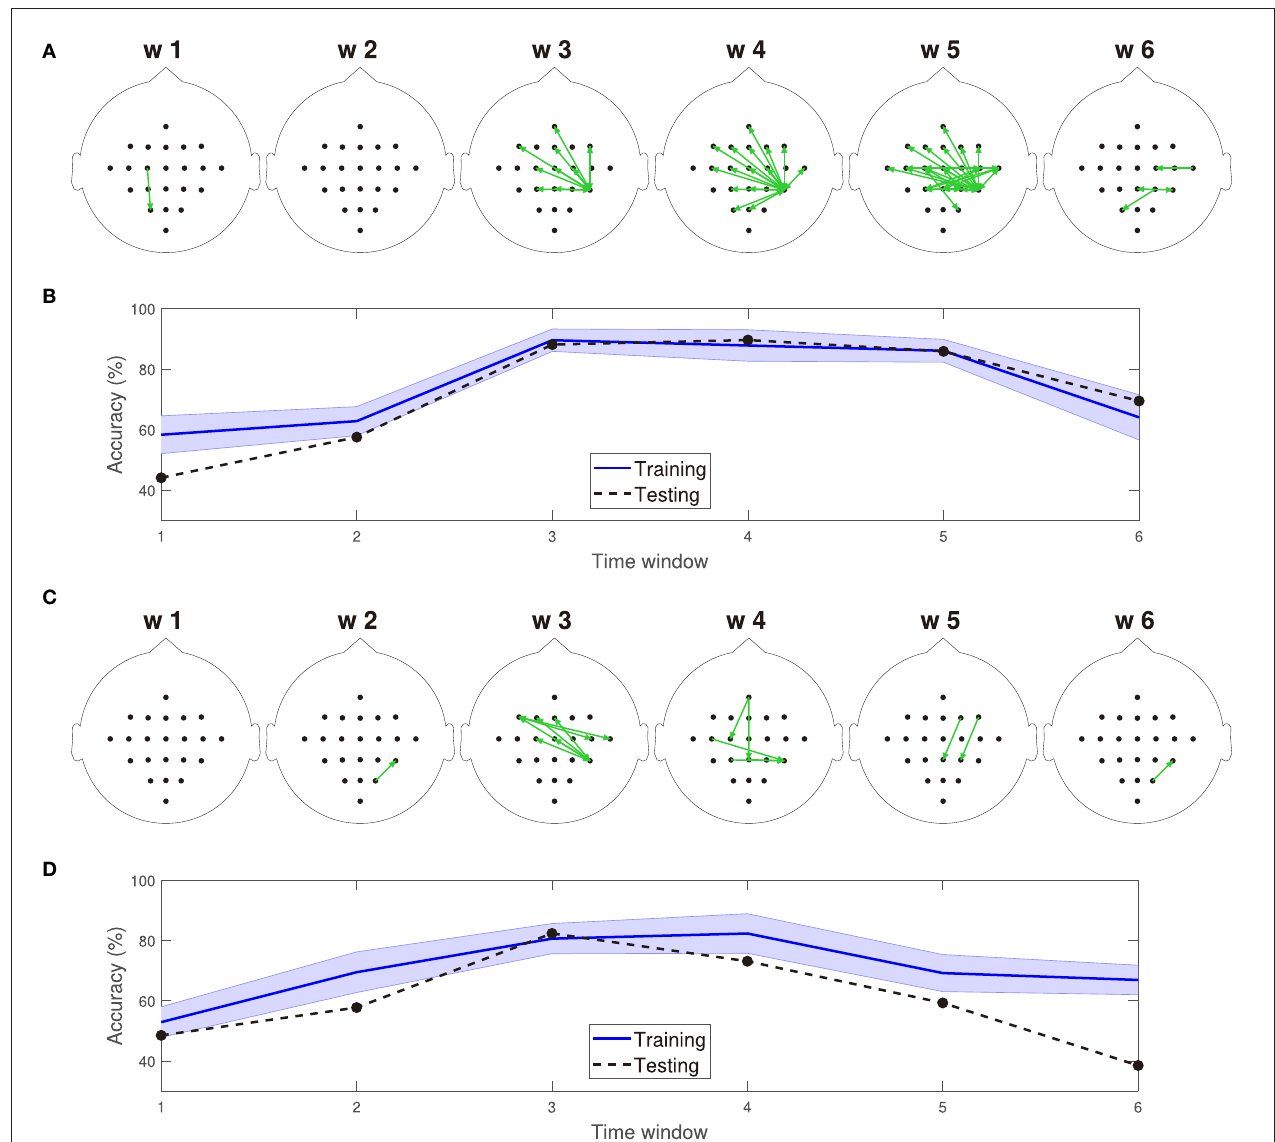
FIGURE 5 | (A) Connections with statistically significant differences between the MI tasks for time windows 1–6 for subject 8. (B) Training and testing classification accuracies per time window for subject 8. (C) Connections with statistically significant differences between the MI tasks for time windows 1–6 for subject 9. (D) Training and testing classification accuracies per time window for subject 9. For visualization purposes, only 10% of the statistically significant connections, those with the smallest p -values, are depicted in (A,C) . windows 1 and 2, and large localized differences during the time windows corresponding to MI execution. We can also observe a trend regarding the spatial location of the information flow differences. For the top 4 subjects, particularly for time window 3, they are centered around the centro-parietal region, specifically channel CP4. For the subjects at the bottom of the plot, the same temporal and spatial patterns are not present. Here, it is worth noting that we have focused our analyses on the differences in the obtained effective connectivities for the left and right MI tasks, instead of analyzing the connectivities that arise for each task as compared with the resting state (Gong et al., 2018).